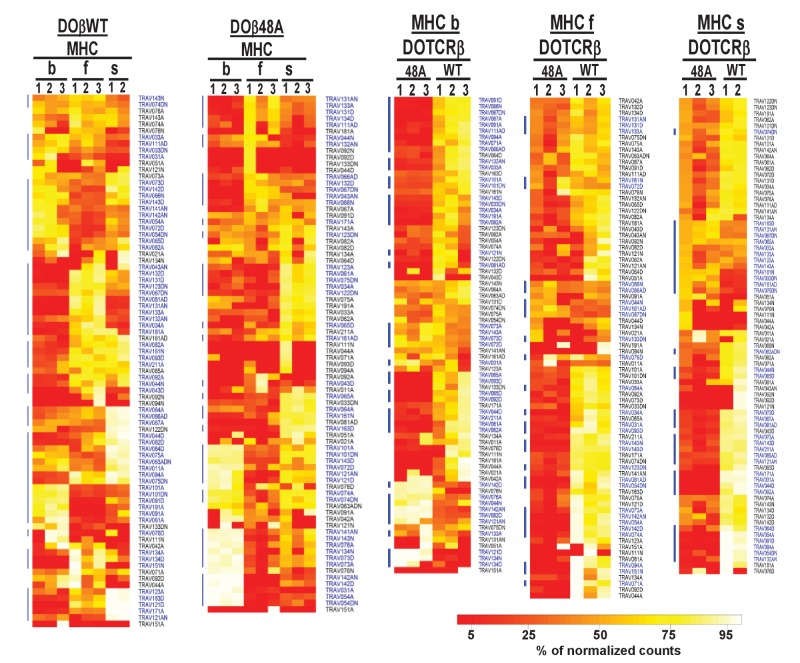
TRAVs are used to different extents by naïve CD4 T cells in mice expressing different MHCII alleles and/or different TCRβs.Data were obtained and analyzed as described in Figures 3 and 5. DESeq2 was used to compare the frequencies with which different TRAVs were used by naïve CD4 T cells in mice expressing different MHCII alleles and/or different TCRβs. Differential expression analyses were performed using the DESeq2 package (v1.8.1) in the R language (v3.2.2). DESeq2 fit negative binomial regression models to each feature to compare between groups. Corrections for size factors for each sample (animal) to account for differences in repertoire size were applied. The negative binomial dispersion parameter for each feature was then calculated, sharing information across features with similar expression levels to moderate extreme empirical dispersion estimates. Wald tests were applied to each feature to test for differential expression between groups. Features were considered differentially expressed if they had a Benjamini-Hochberg adjusted p-value (i.e., false discovery rate)<0.05.